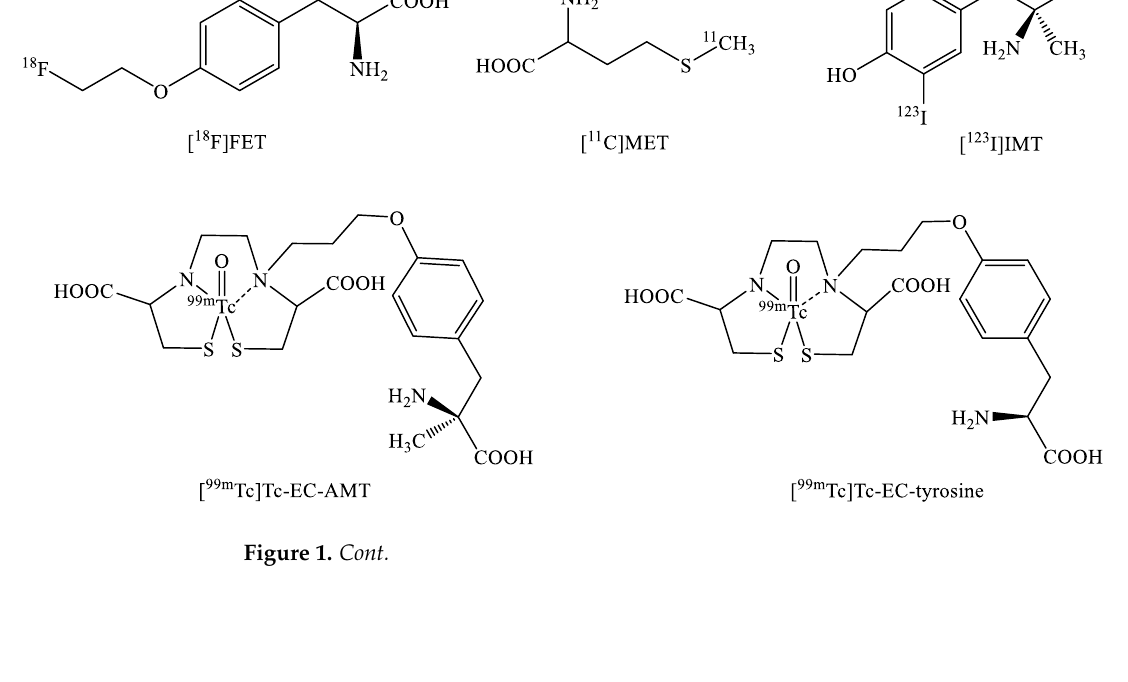
Figure 1. The proposed chemical structures of some mentioned radiolabeled amino acids. 2. Materials and Methods 2.1. Reagents and Chemicals All chemicals were purchased from commercial sources and used without further purification. Mass spectrum was recorded on a Triple TOF 5600 spectrometer (Concord, Canada). The NMR results were acquired on a 400 MHz JNM-ECS spectrophotometer (JEOL, Tokyo, Japan). Technetium-99m solution ([ 99m Tc]TcO 4 − ) was eluted freshly from a 99 Mo/ 99m Tc generator, which was purchased from ZHIBO Bio-Medical Tech, Beijing, China. Succinic dihydrazide (SDH) kits and glucoheptonate (GH) kits were obtained from Beijing Shihong Pharmaceutical Co., LTD (Bejing, China), Beijing Normal University, China. SPECT/CT imaging studies were performed on a SPECT/CT scanner, which was pur- chased from TriFoil imaging (Chatsworth, CA, USA). 2.2. Synthesis of MOPADTC MOPADTC was prepared according to a previously reported method [23]. NaOH (0.413 g, 10 mmol) was added to water (20 mL) and stirred at room temperature. Then, 4- methoxy- L -phenylalanine (1.0 g, 5 mmol) was added to the above solution and stirred un- til it was completely dissolved. Carbon disulfide (3 mL, 50 mmol) was added to the above